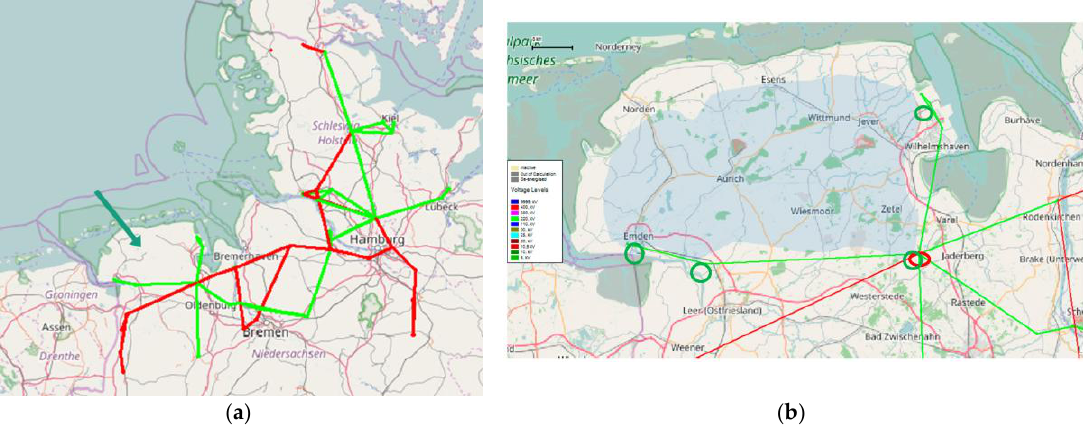
Figure 9. Transmission grid model in PowerFactory ( a ) (the arrow indicates the DSO grid position), and area of the distribution grid with CPs ( b ).